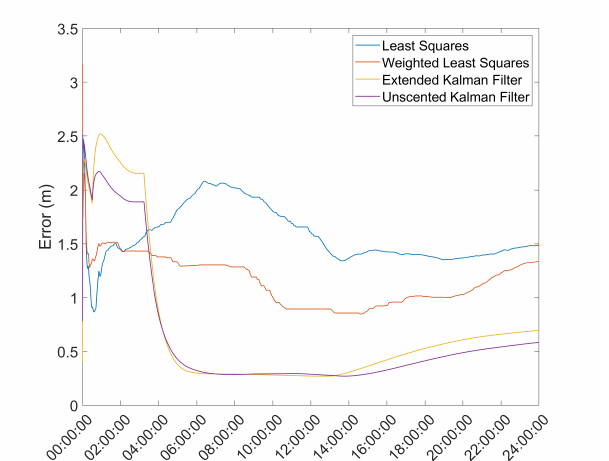
Figure 9. Effect of a 2 σ threshold on the mean error over time for the reference station antenna with Hatch Filter and γ = 0.010.